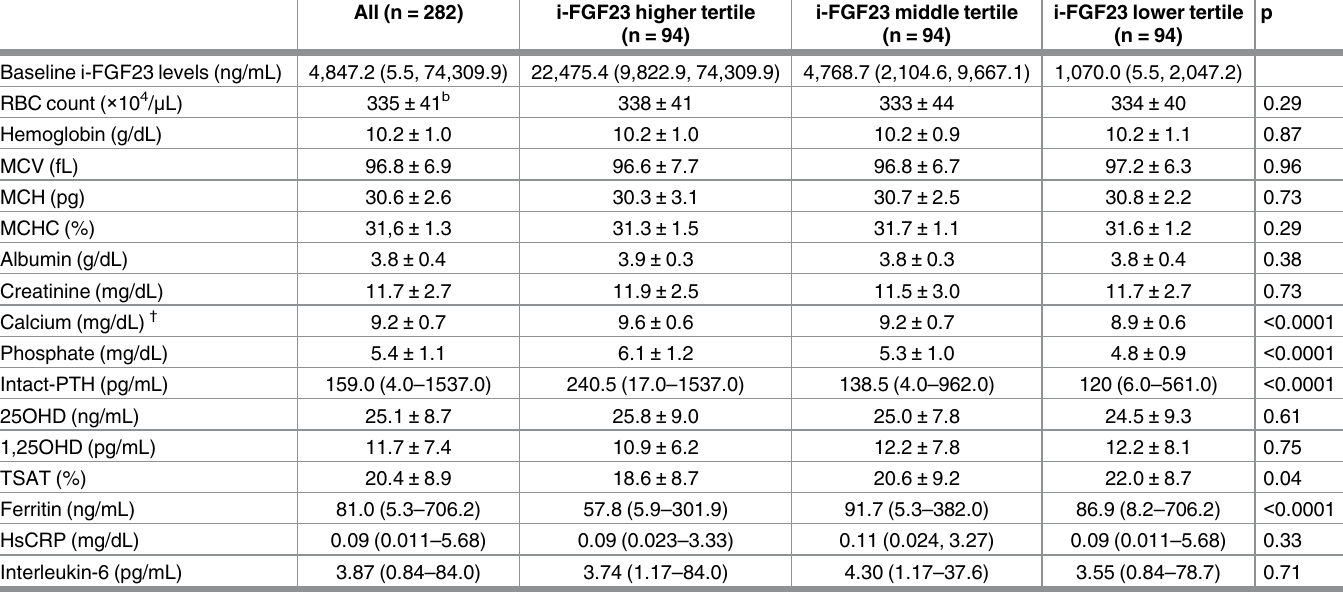
Table 2. Laboratory findings at baseline.